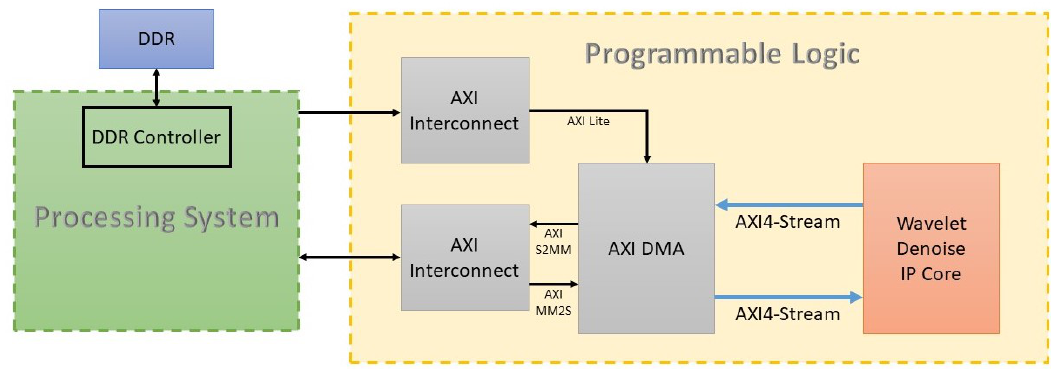
Figure 9. Wavelet Denoise IP core within the hardware platform.